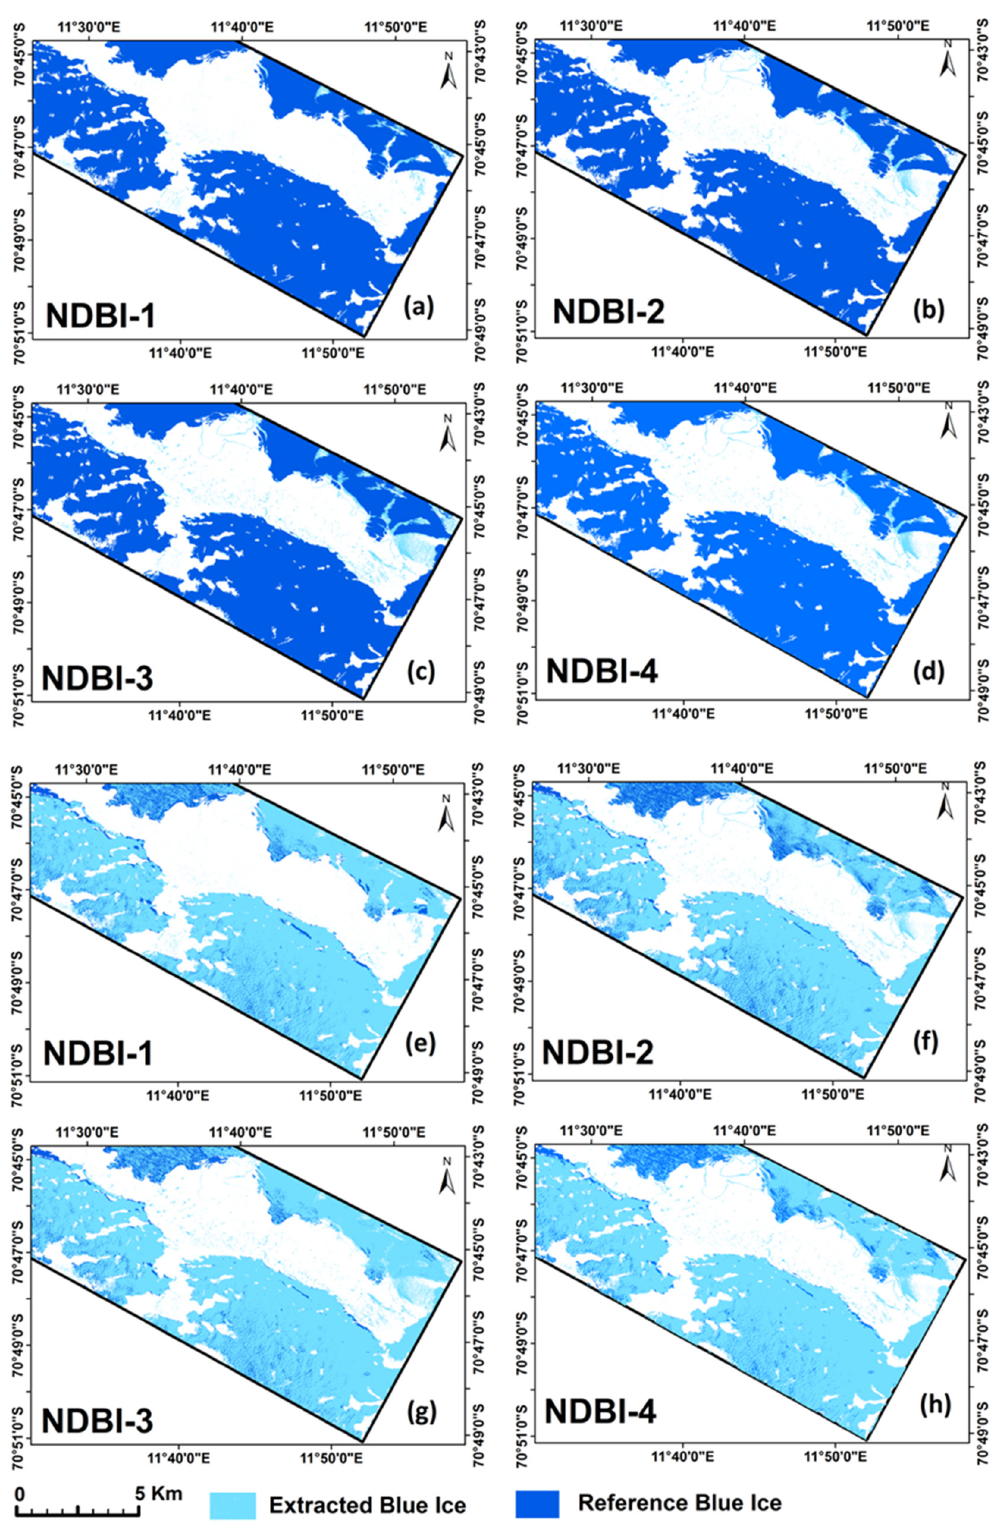
Figure 9. Visual image analysis of extracted blue ice regions from the entire study area using four NDBI methods under a customized NDBI approach: ( a – d ) represent reference manually-digitized blue ice over the semi-automatically extracted blue ice to infer the spatial distribution of overestimated blue ice pixels; ( e – h ) represent the semi-automatically extracted blue ice over reference manually-digitized blue ice to infer the spatial distribution of underestimated blue ice pixels.